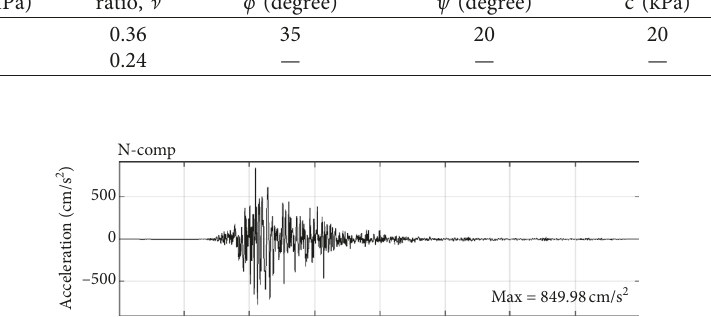
Figure 1: Acceleration history, northern Norcia Italy earthquake of 30 Oct 2016 [13].